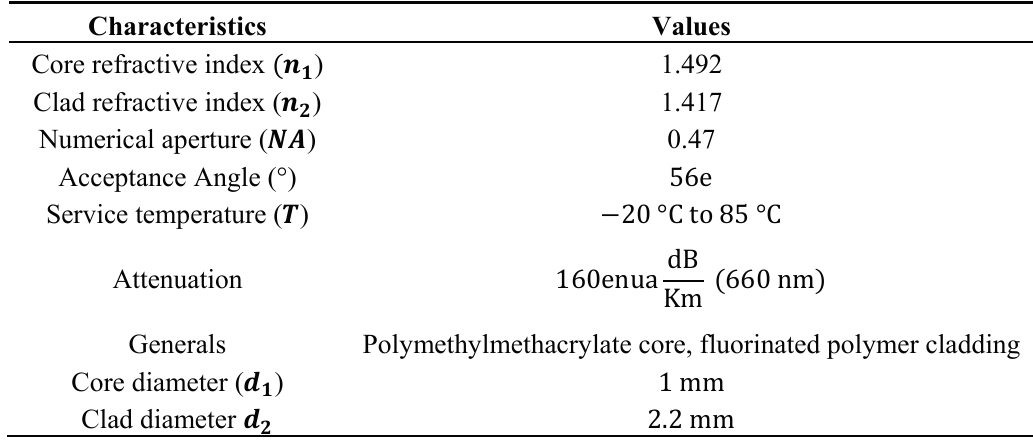
Table 1. Optical fiber specifications [26].